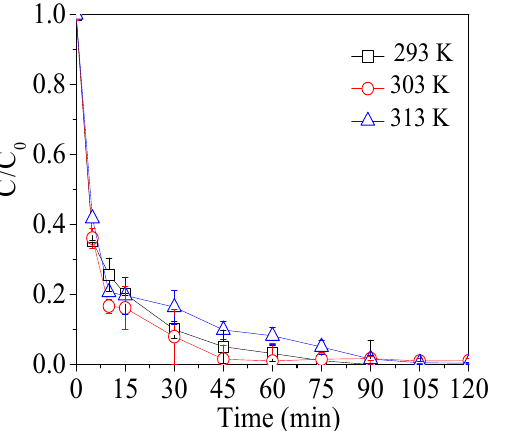
Figure 4. Removal efficiency of Cr(VI) by nZVI at different initial temperature.([Cr(VI)]= 25 mg/L, [nZVI] = 0.5 g/L, pH = 3).